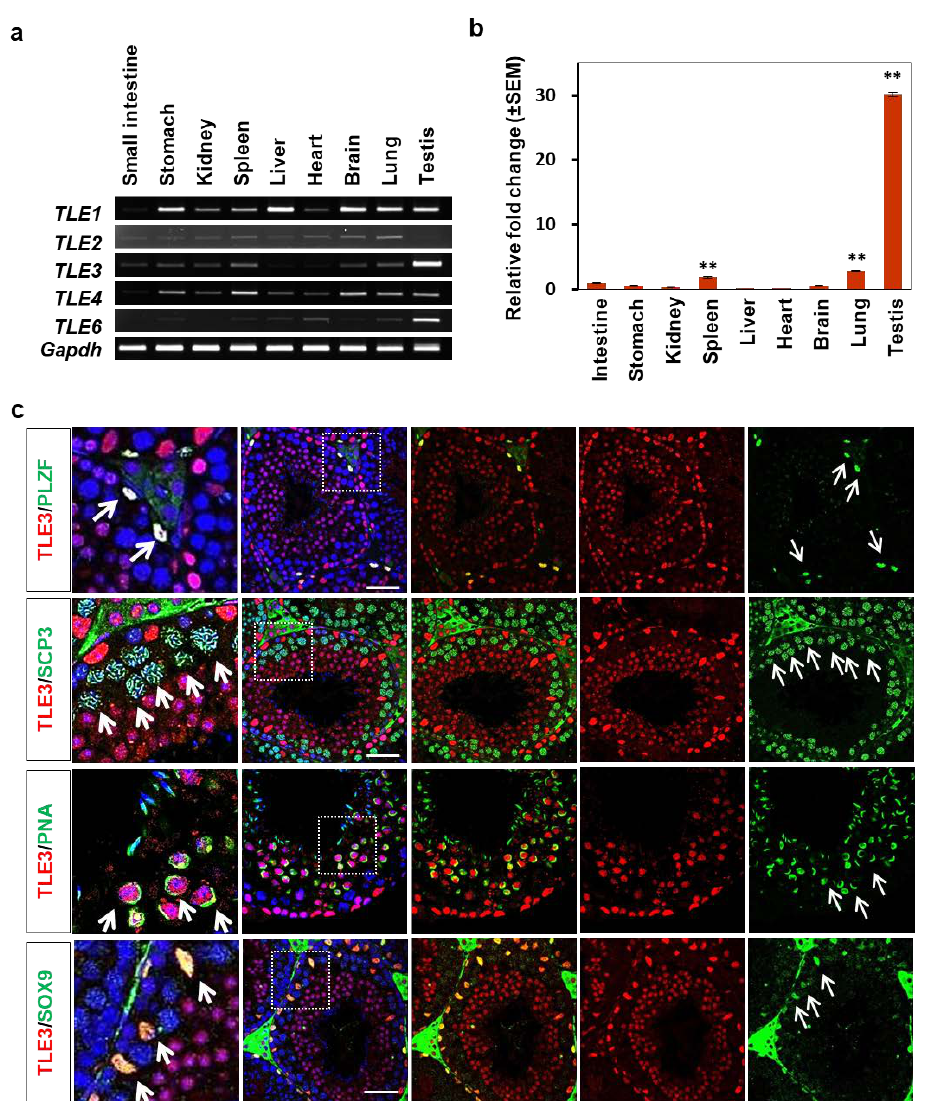
Figure 1. Expression of TLE3 in various tissues and seminiferous tubule in the testes of a mouse. The mRNA was isolated from the tissues of six-week-old male mice. ( a , b ) RT-PCR and qRT-PCR analysis of TLE family members (TLE1, TLE2, TLE3, TLE4, and TLE6) in various mouse tissues (intestine, stomach, kidney, spleen, liver, heart, brain, lung, and testis). Relative expression level of TLE3 was normalized with Gapdh transcript. Data are represented as mean ± SEM. The Student t -test was applied to calculate p -value. **p < 0.01. ( c ) Immunofluorescence analysis of TLE3 and each stage markers (PLZF, SCP3, PNA, and SOX9) in the seminiferous tubules of the testes of a 6-week-old mouse. Arrows indicate the positive cells with cell-specific antibody. PLZF: spermatogonium marker; SCP3: spermatocyte marker; PNA: acrosome of spermatid marker; SOX9: Sertoli cell marker. DNA was stained with 4′ ,6-diamidino-2-phenylindole (DAPI). The dotted box with white line represents the magnified region (first column). Scale bar represents 50 μm.